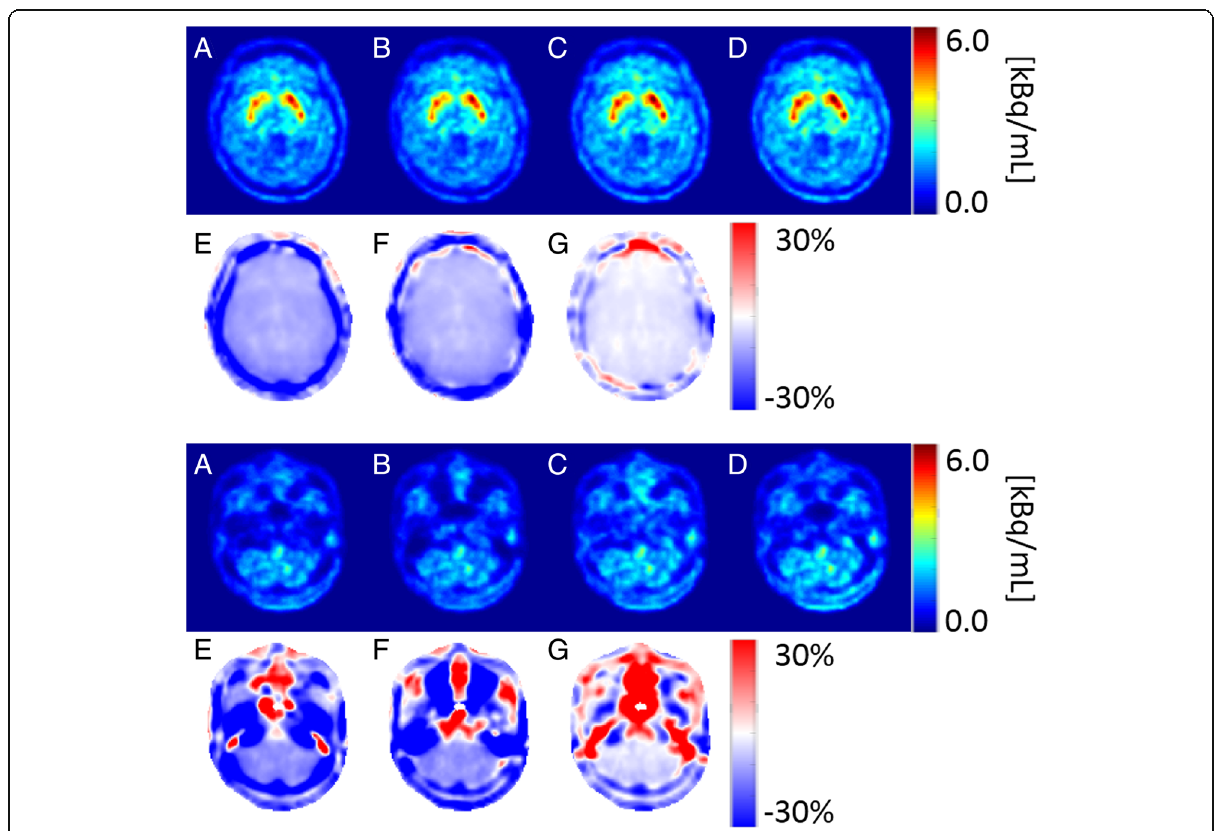
Fig. 2 Axial slices of the last PET frame (65 – 70 min) from one subject at the height of striatum and occipital pole (top), and cerebellum (bottom) reconstructed using μ -map DXN (A), μ -map dUTE (B), μ -map dUTE − R2 (C), and pCT (D). En between the PET datasets obtained using μ -map DXN (E), μ - map dUTE (F), and μ -map dUTE − R2 (G) with